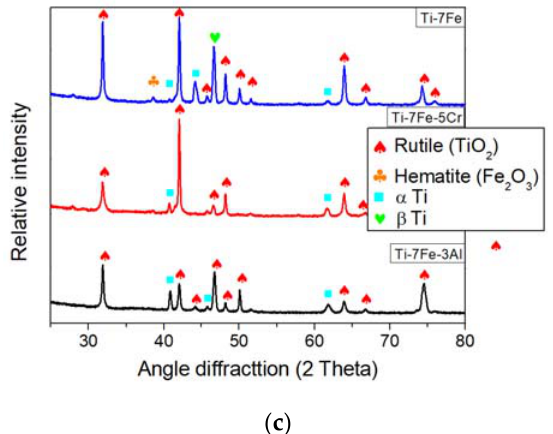
Figure 12. Backscattered electron image of cross section of ( a ) Ti ‐ 7Fe ( b ) Ti ‐ 7Fe ‐ 5Cr, and ( c ) XRD patterns of samples tested at 500 °C for 300 h .